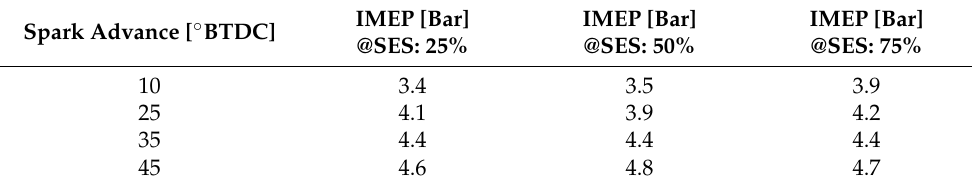
Table 6. IMEP [Bar] values for different spark advance and syngas energy share.